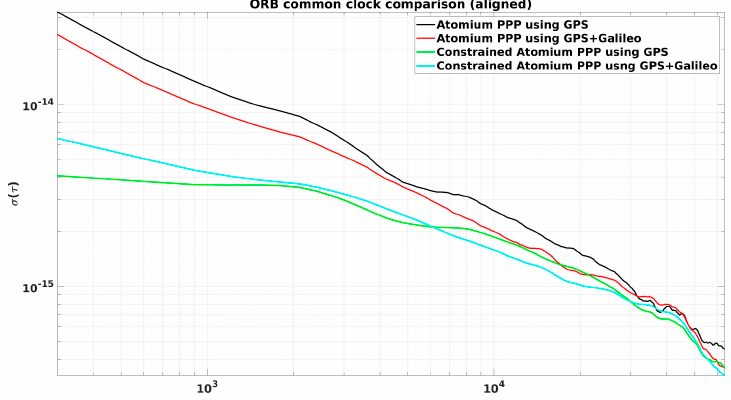
Figure 7. ADEVs of aligned CCD results in ORB.